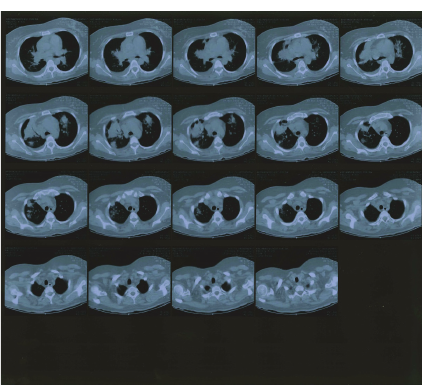
Figure 1: Acute pneumonia caused by Streptococcus pneumoniae alone in a 33-year-old female, 6 days after the onset of fever, cough, and dyspnoea. Transverse high-resolution CT image at the level of theright upper lobeshows consolidation, centrilobular nodules, and bronchial wall